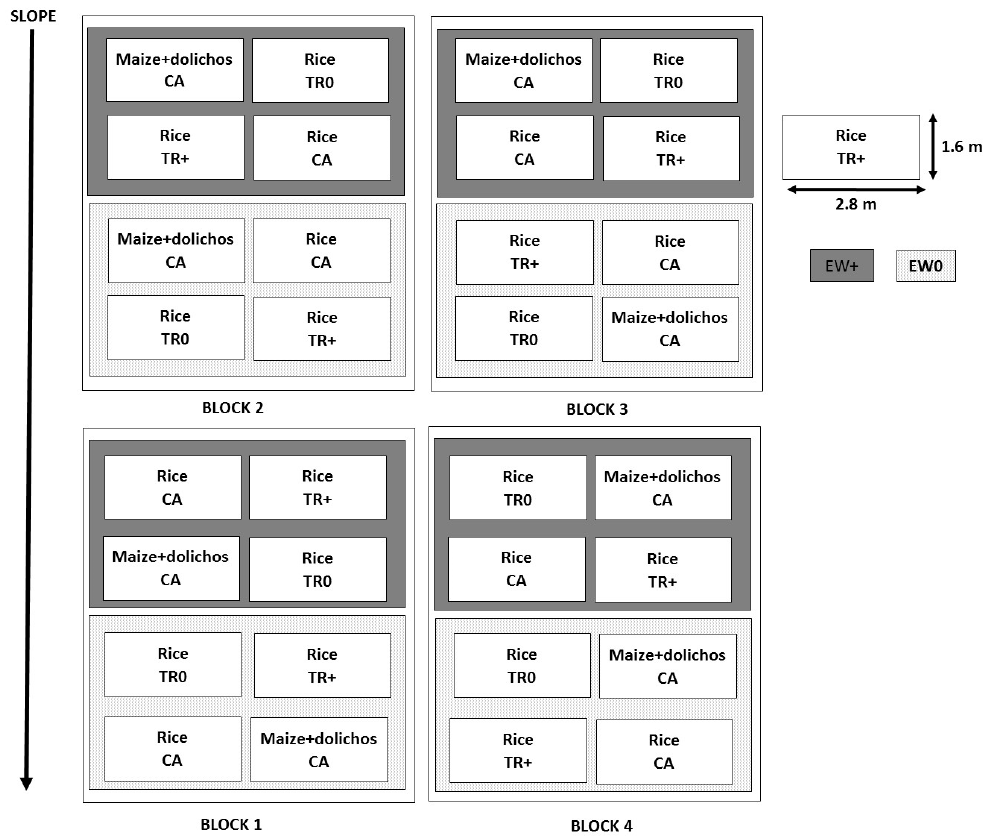
Figure 1. Experimental design. Treatments are abbreviated as follows: EW0: without earthworm inoculation, EW+: with earthworm inoculation, TR0: traditional tillage without rice residues restitution, TR+: traditional tillage with rice residues restitution, CA: conservation agriculture.